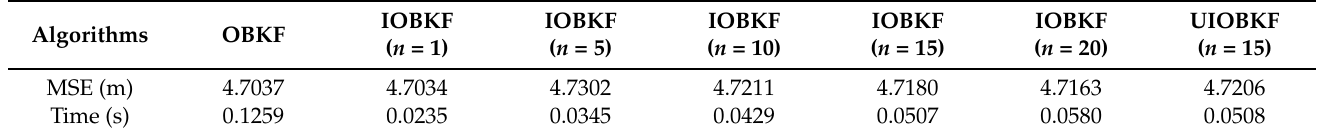
Table 2. Mean value of MSE (40 < k ≤ 100) and the average time for a single-step operation of different algorithms.